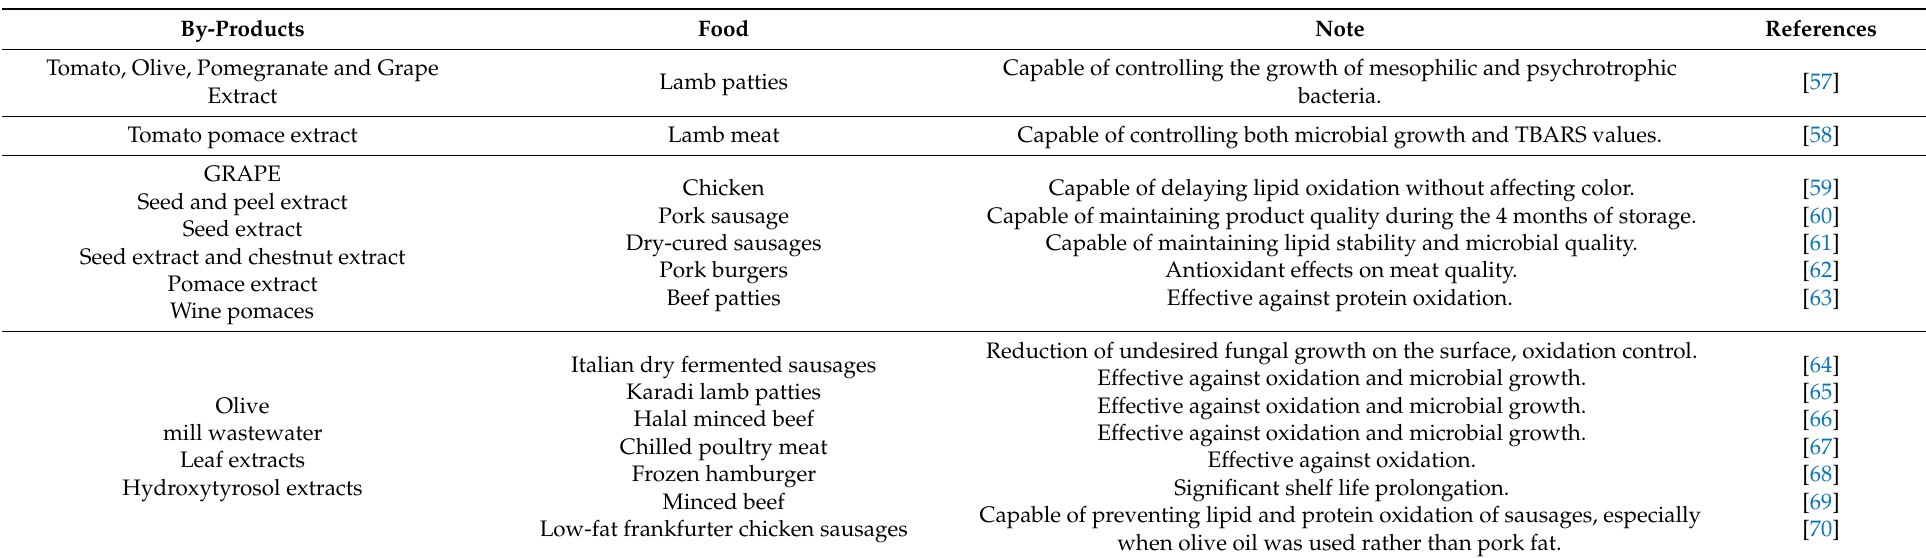
Table 4. Applications of by-products to meat